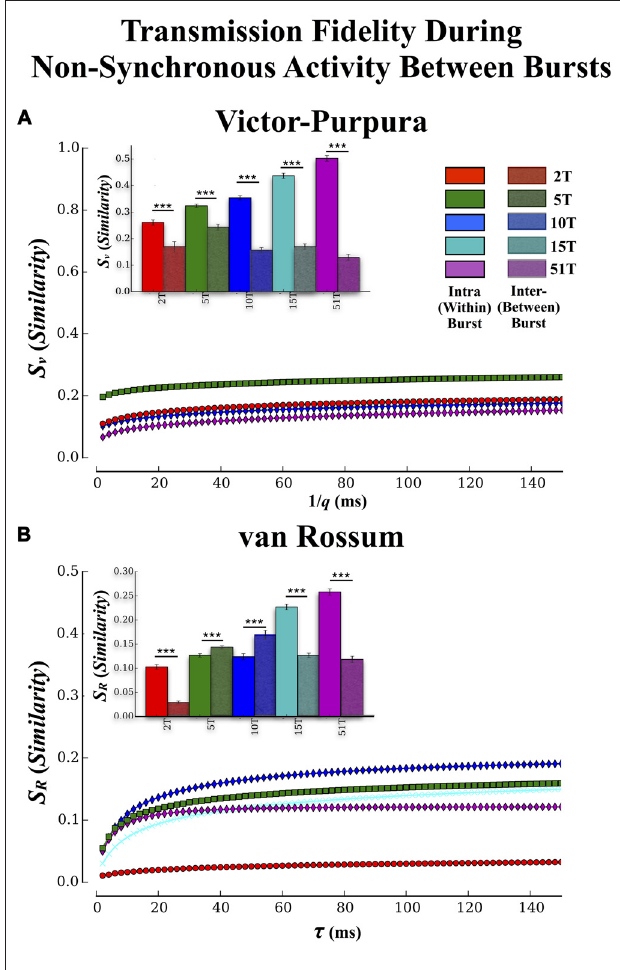
FIGURE 7 | Transmission fidelity during synchronous population bursting vs. asynchronous single unit activity outside bursts . The role synchrony may play during transmission of information among neural populations is still a matter of debate. Almost half of all activity we observed in these cultures occurred during the intervals between population wide bursts of activity. If synchronized bursting promotes information transmission then fidelity should be much higher during transmission within the bursts compared to transmission during the intervals between the bursts. (A,B) show the results of our fidelity estimates based on Victor’s and van Rossums metric, respectively for activity that occurred between bursting compared to within bursting (repeated from Figures 5A,B ). Transmission fidelity was significantly degraded when it occurred in the absence of synchronous firing outside of bursts relative to inside burst events (Error bars represent 95% confidence intervals; ∗∗∗ p <